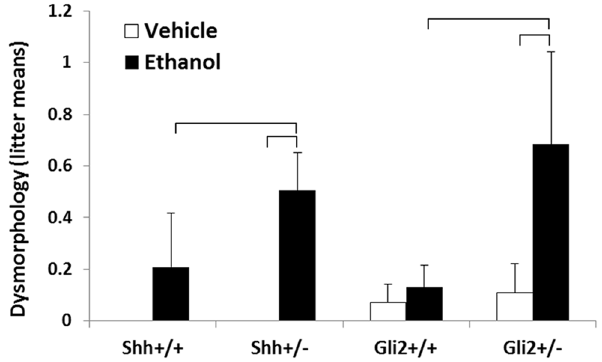
Figure 2. Effect of treatment and genotype on facial dysmor- phology. To avoid litter bias, the average dysmorphology score from each genotypic group was determined for each litter in the study population. Values represent the mean plus the standard error of litter averages for each genotype and treatment. Brackets indicate p values of # 0.05 as determined by a one-tailed student’s t-test.